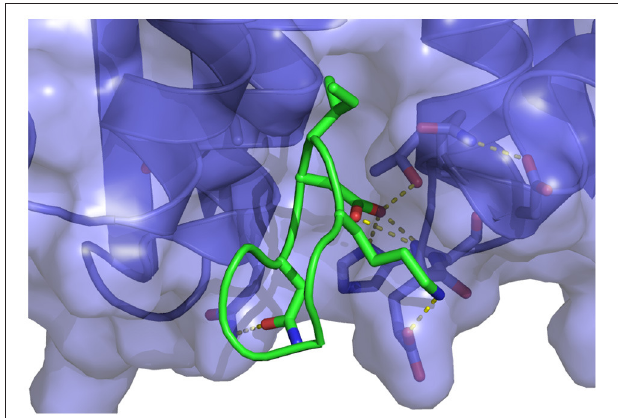
FIGURE 7 | Representative structure extracted from the simulation of the wildtype cyclic peptide (WT in Table 1 ) bound to the LEDGF-binding domain of HIV integrase. The following intermolecular interactions are highlighted: Lys364-Glu170, Asp366-Thr174, His171, and Asn367-Gln95. Also shown in the intramolecular interaction between Asp168 and Gln169 of the peptide and the key bidentated interaction between Asp366 and the backbone nitrogen atoms of Glu170 and